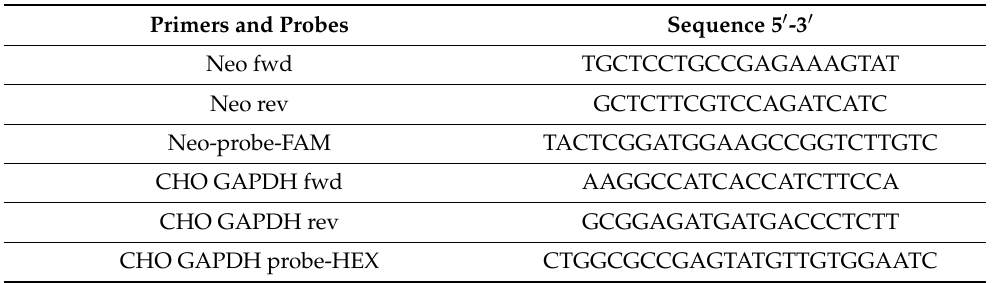
Table 1. Sequence of primers and probes used in duplex qPCR for analyzing virus entry. Primers and